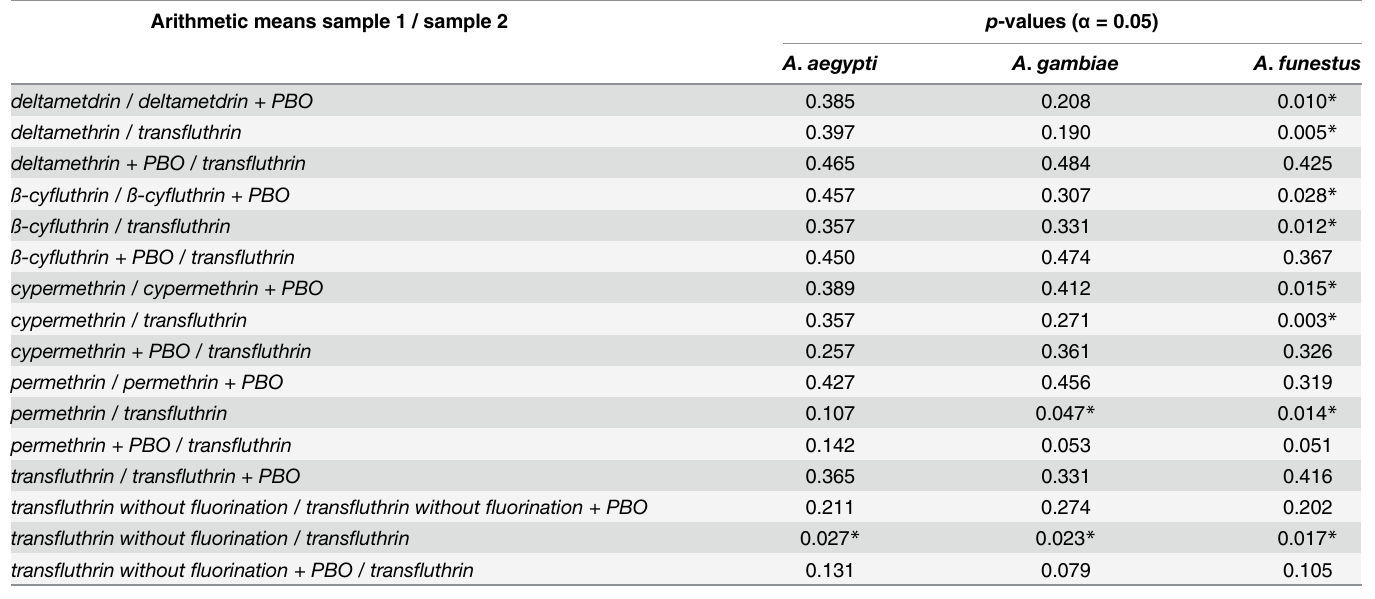
Table 2. p -values of a one-sided Student´s t-test comparing the arithmetic means of different samples.